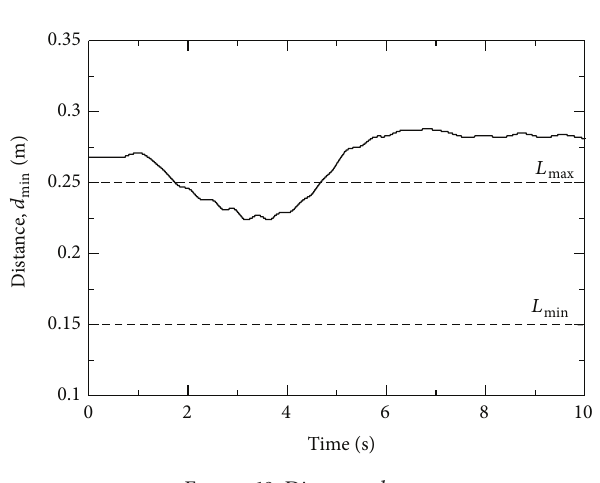
Figure 19: Distance, 𝑑 min